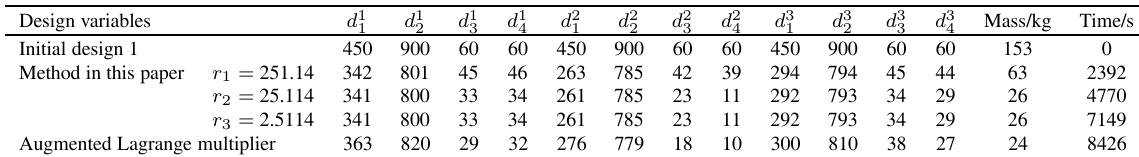
Table 2 Initial feasible design 1 and optimum design (unit: mm)